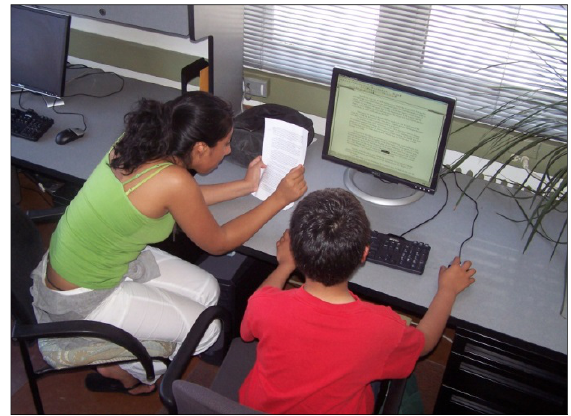
Figure 3. A Children, Youth and Environments Center (CYE) intern and a Boulder youth developing the narrative for a digital story at the CYE Center (photo courtesy of Debra